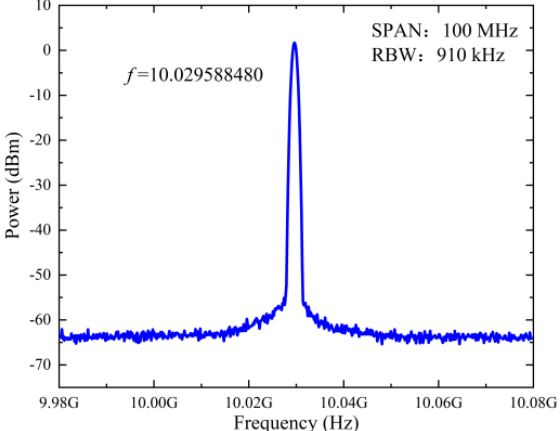
Figure 4. The generated 10 GHz microwave power spectrum of the coupled dual-loop SBS-based TOEO with span of 100 MHz.